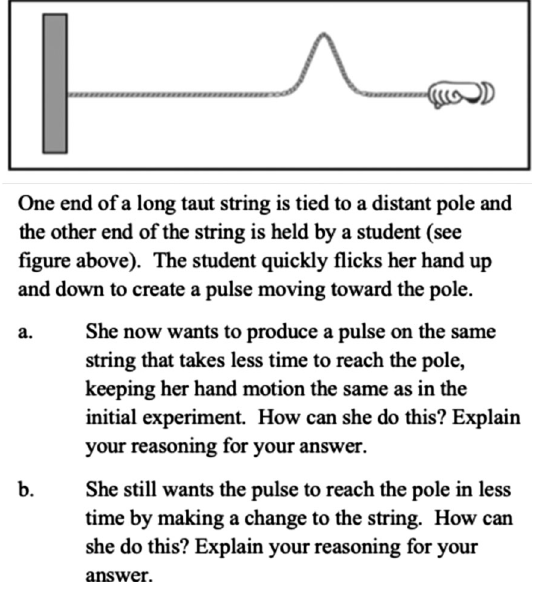
FIG. 3. The predict-style question on pulse propagation (the original pulse-flick question). This question is modified from Wittmann [20].